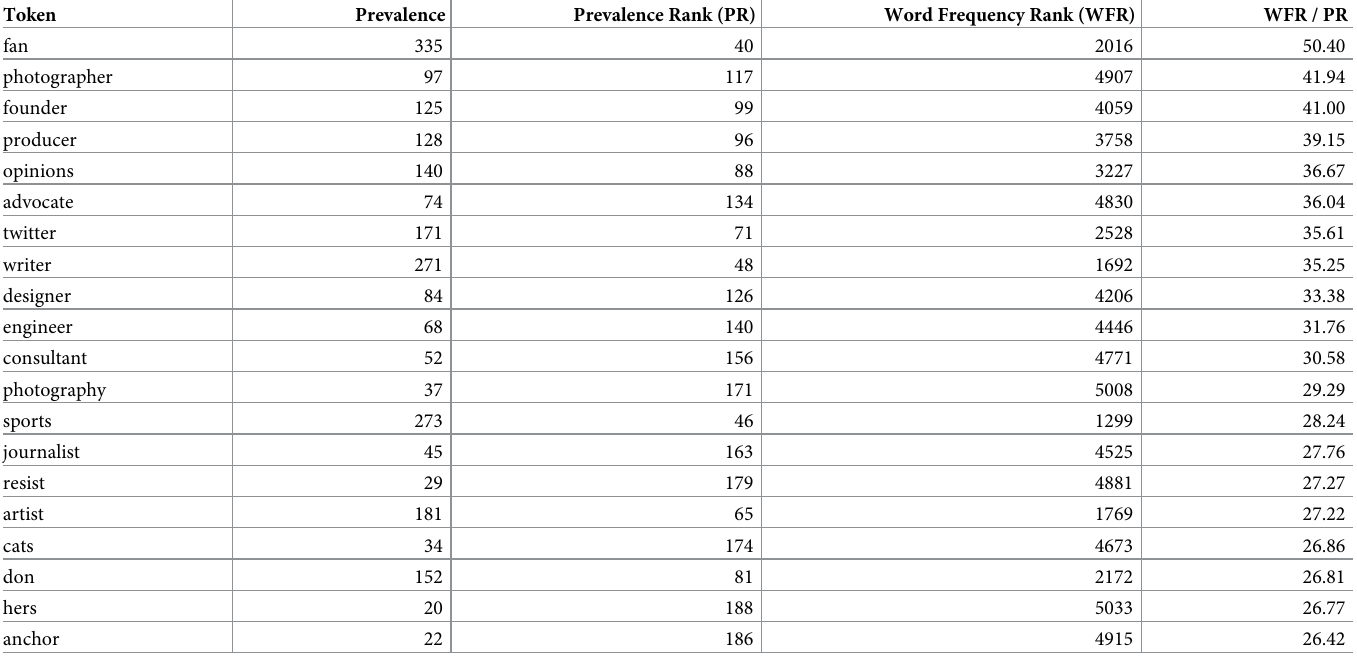
Table 3. The 20 most-surprisingly common tokens from the longitudinal sample in 2020.